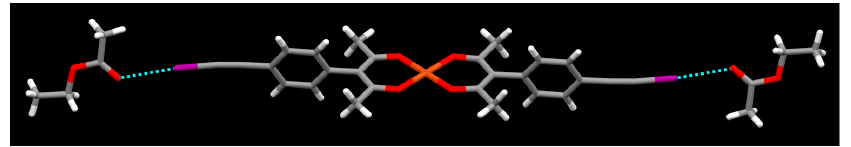
Figure 13 : Part of the crystal structure of [Cu( L3) 2 ]·2C 4 H 8 O 2 showing the geometry around the metal ion and the ligand-solvent halogen bond (color codes: red—oxygen; purple—iodine; orange—copper). Without any axially coordinated ligands, adjacent complex ions are again close enough to form stacks as a result of intermolecular C-H···O hydrogen bonding between phenyl rings and acac moieties (Figure 14) ca. r (O···H) 2.63 Å and 2.76 Å.